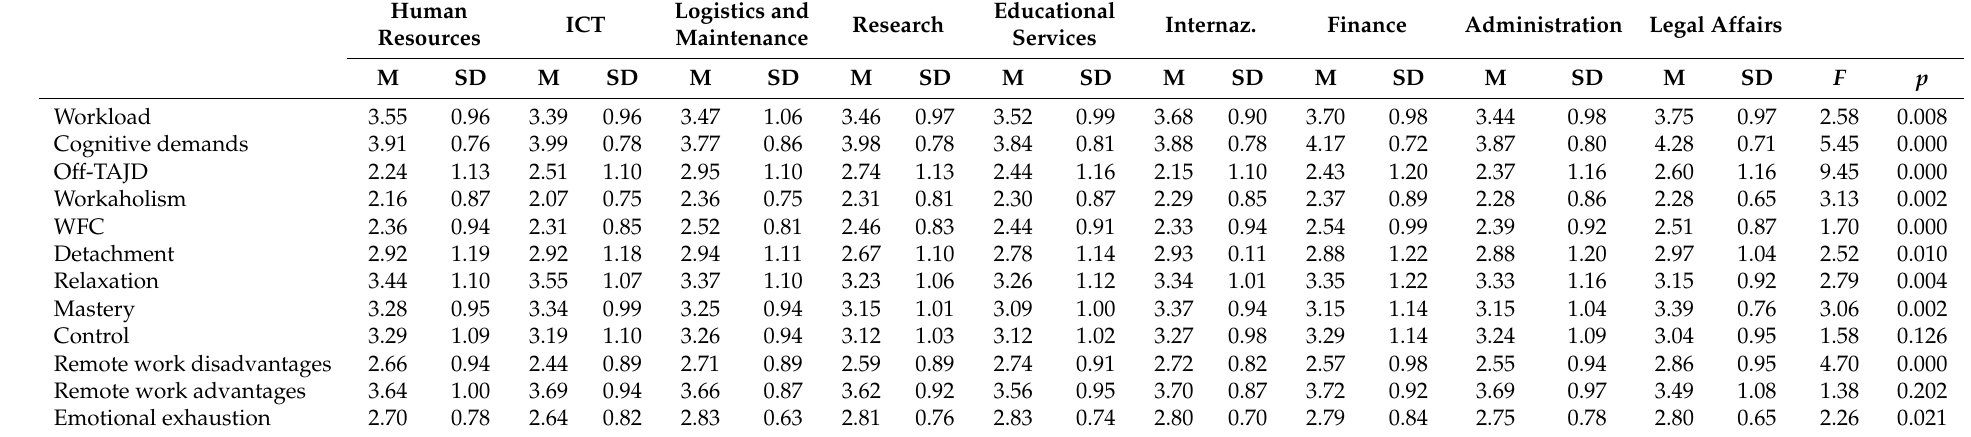
Table 2. Means, standard deviations, and ANOVA for the TAS sample by work areas. Human Resources